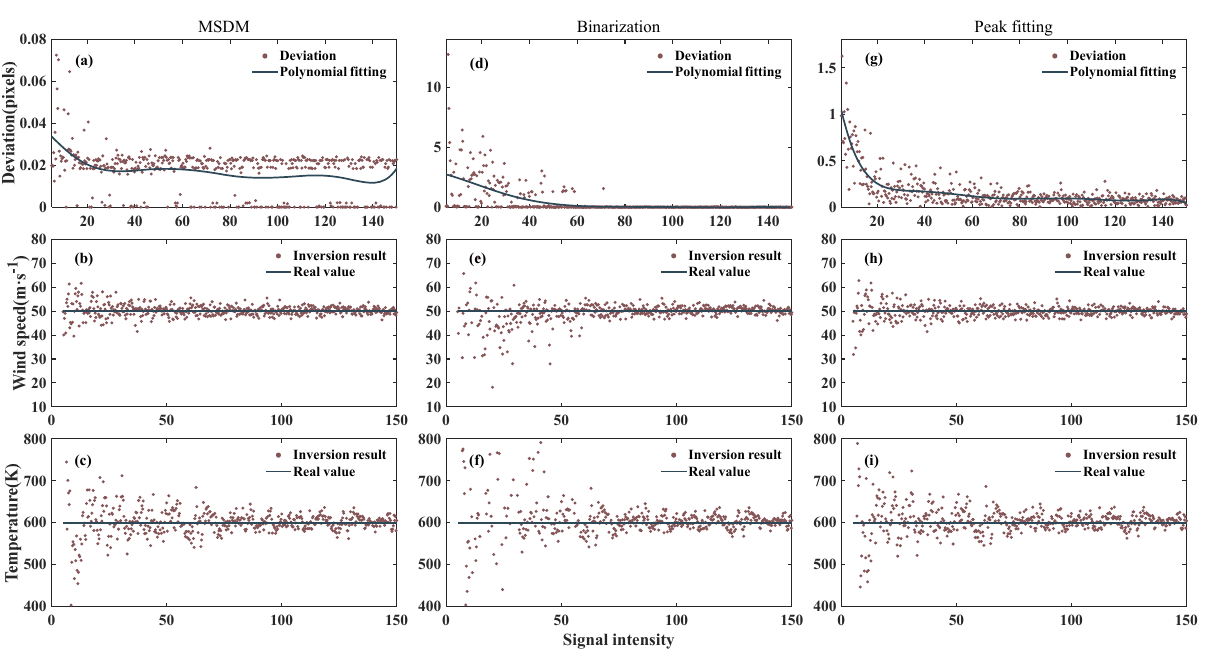
Figure 7. Same as Figure 6, but for Poisson noise.